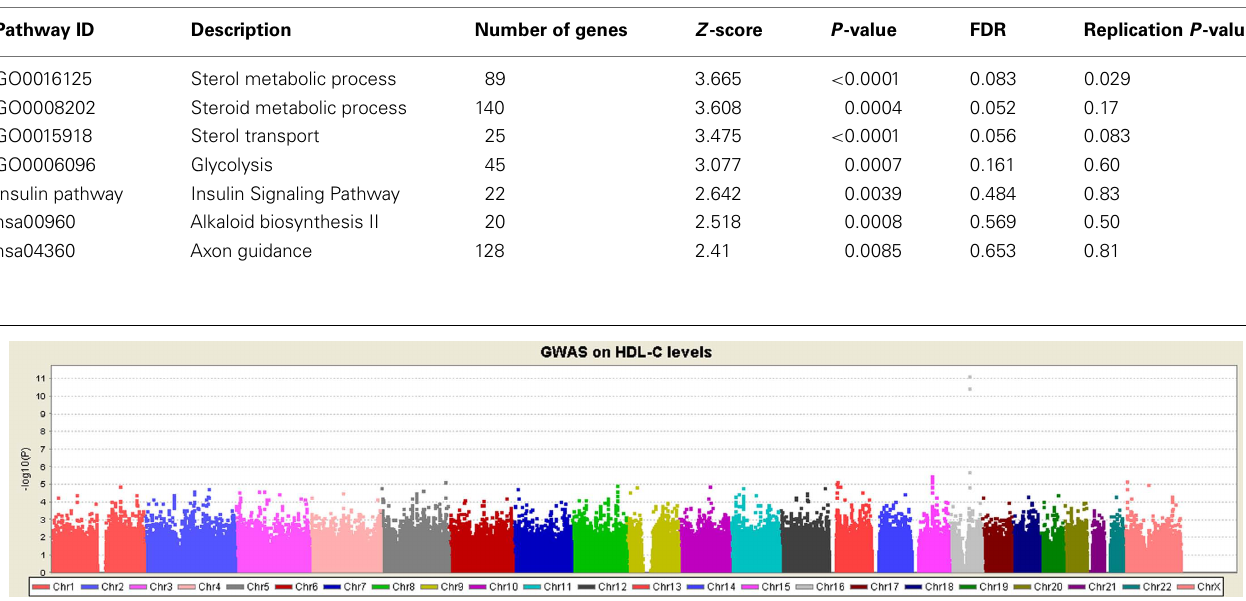
FIGURE 1 | Manhattan plot of the single-marker association analysis on the discovery cohort. Except CETP on 16p13.3, single-marker analysis failed to identify any locus reaching genome-wide significance ( P < 5 × 10 − ] ).